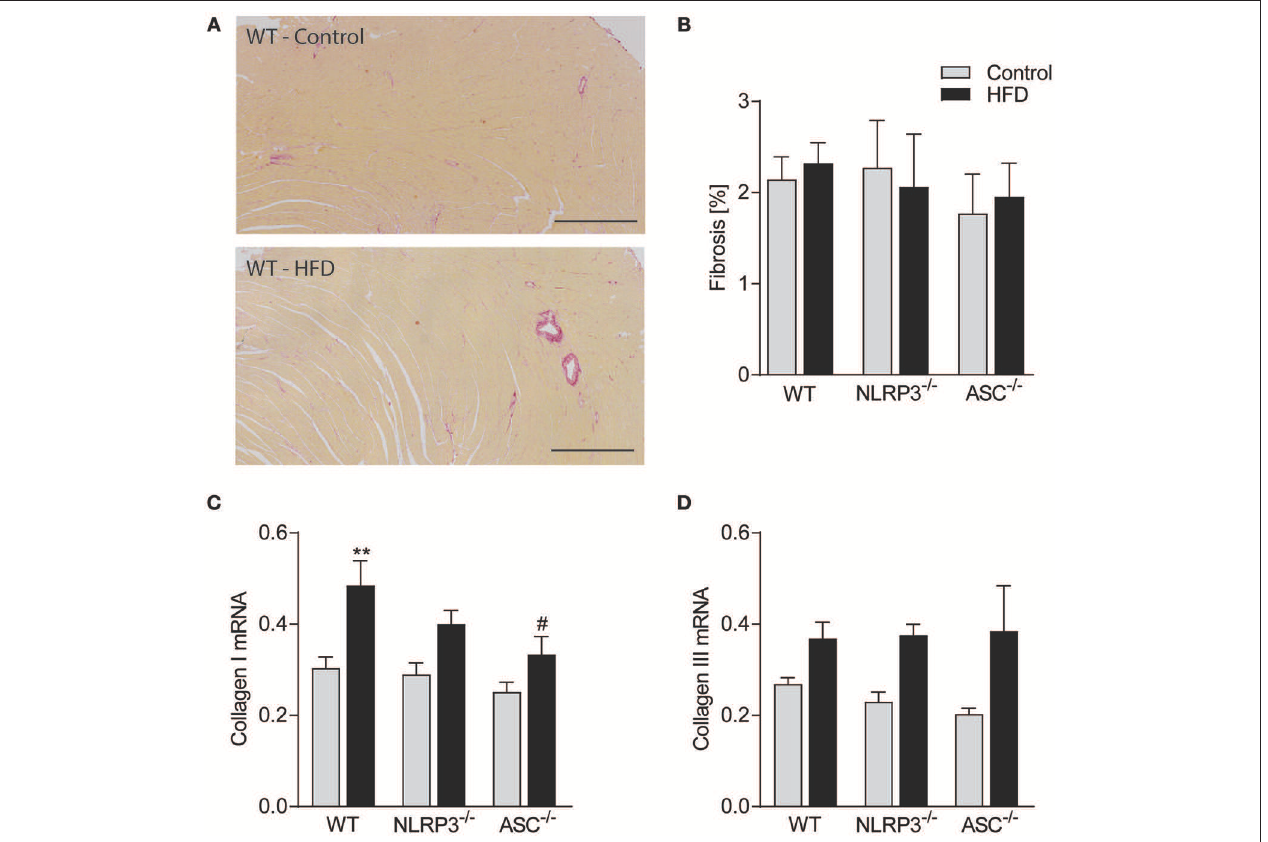
FIGURE 5 | Obesity-induced LV remodeling is not associated with cardiac fibrosis. WT, Nlrp3 − / − , and Asc − / − ( Pycard − / − ) male mice were exposed to high fat diet (HFD; 60 cal% fat) or control diet for 52 weeks and cardiac fibrosis was evaluated. (A) Representative images of picrosirius red stained left ventricle (LV) from a WT mouse on control diet and HFD. Scale bar: 500 µ m. (B) Quantification of picrosirius red positive areas in LV. LV expression of (C) collagen I mRNA and (D) collagen III mRNA. WT: Control, n = 10; HFD, n = 10, Nlrp3 − / − : Control, n = 7; HFD, n = 7, and Asc − / − ( Pycard − / − ): Control, n = 7; HFD, n = 7. Data are shown as mean ± SEM. ** P < 0.01 vs . control diet; # P < 0.05 vs. WT-HFD as determined by two-way ANOVA and Tukey’s multiple comparisons